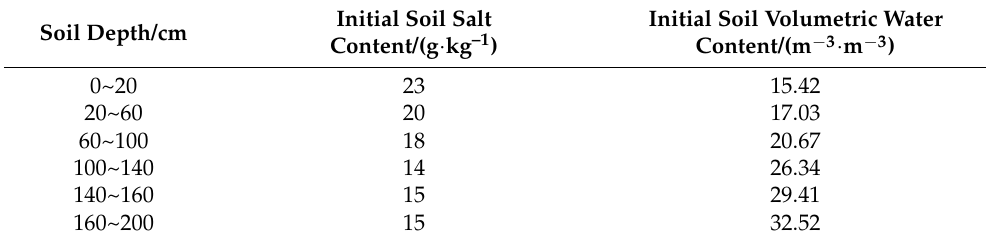
Table 3. Initial salt content and initial moisture content of each soil layer. Soil